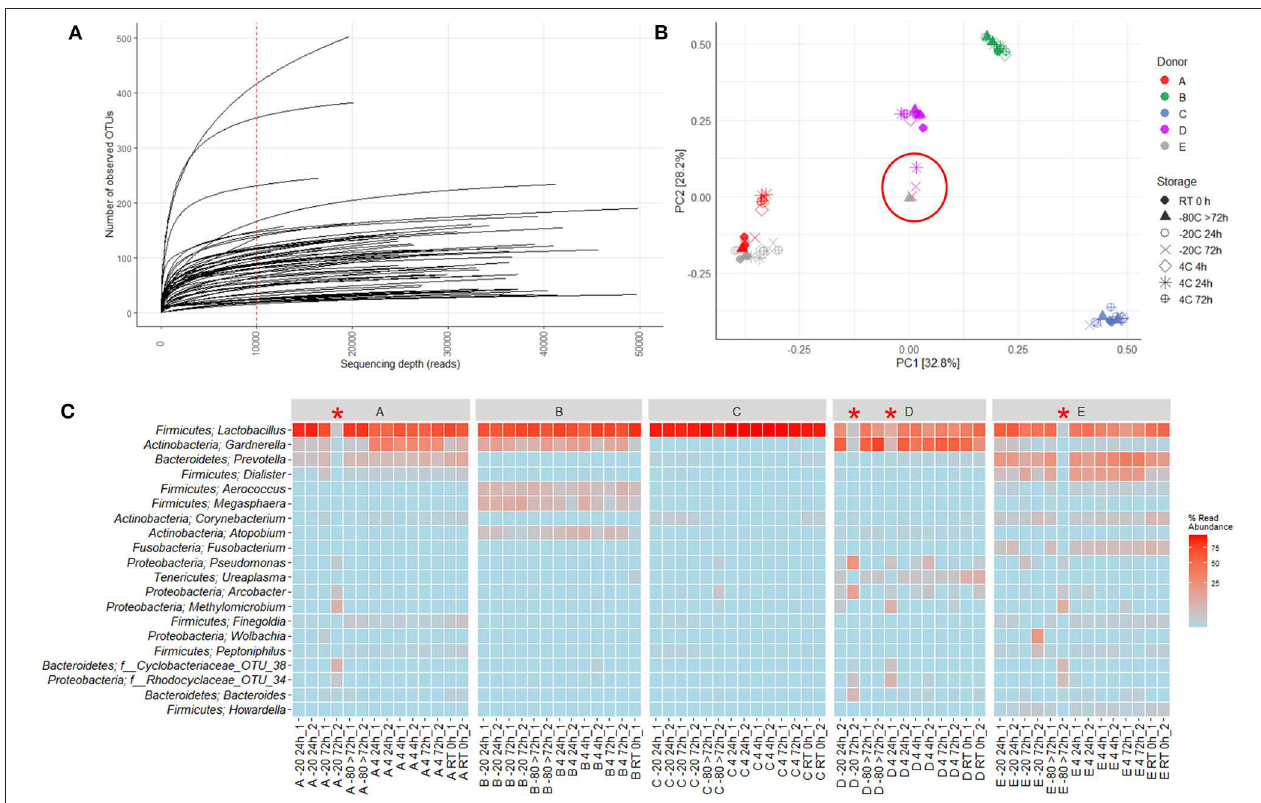
FIGURE 3 | Quality control used for removing low quality samples. 16S rRNA gene sequencing of the V4 region gave rise to 2,097,325 reads (median 29,334, range 1,299–132,881 reads per sample). 933 unique OTUs were identified (median 106, range 33–502 OTUs per sample), with taxonomy assigned at the phylum level for 96.1% of OTUs and genus level for 53.2%. (A) Rarefaction Curve showing number of unique OTUs generated based on quantity of reads. The red dotted line indicates cutoff value of 10.000 reads. Three samples were excluded due to values below cutoff. (B) PCA based on Hellinger transformed OTU abundances. (C) Heatmap depicting the 20 most common OTUs for each separate duplicate. Each name consists of phylum followed by genus name. If no genus could be identified, the best taxonomic assignment is listed. The heatmap and PCA were used to identify potential outliers. The following four samples were excluded: A − 20 72 h_2,